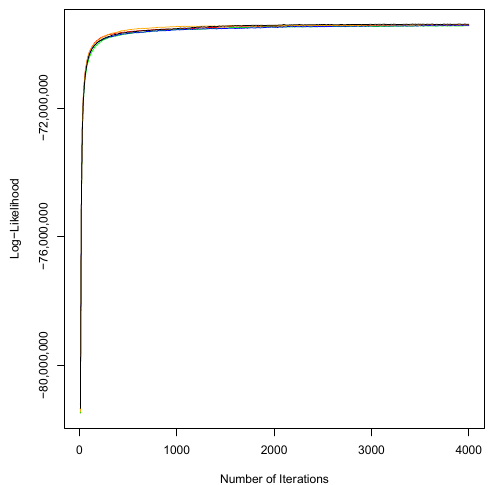
Figure 2. Convergence of the log-likelihood for five sets of 4000 integrations.